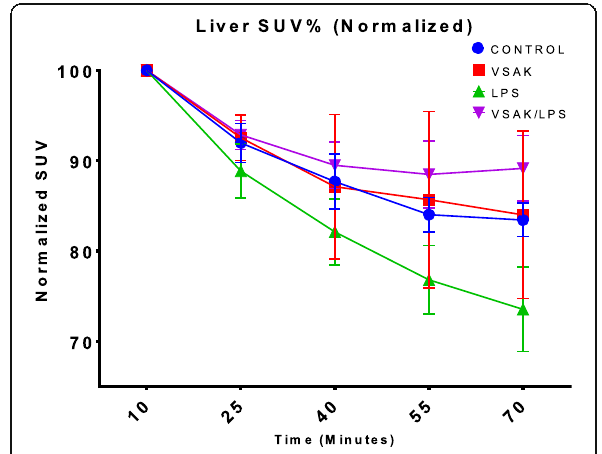
Fig. 2 (abstract P38). Standard Uptake FDG Values (SUV) from the four representative experimental animal